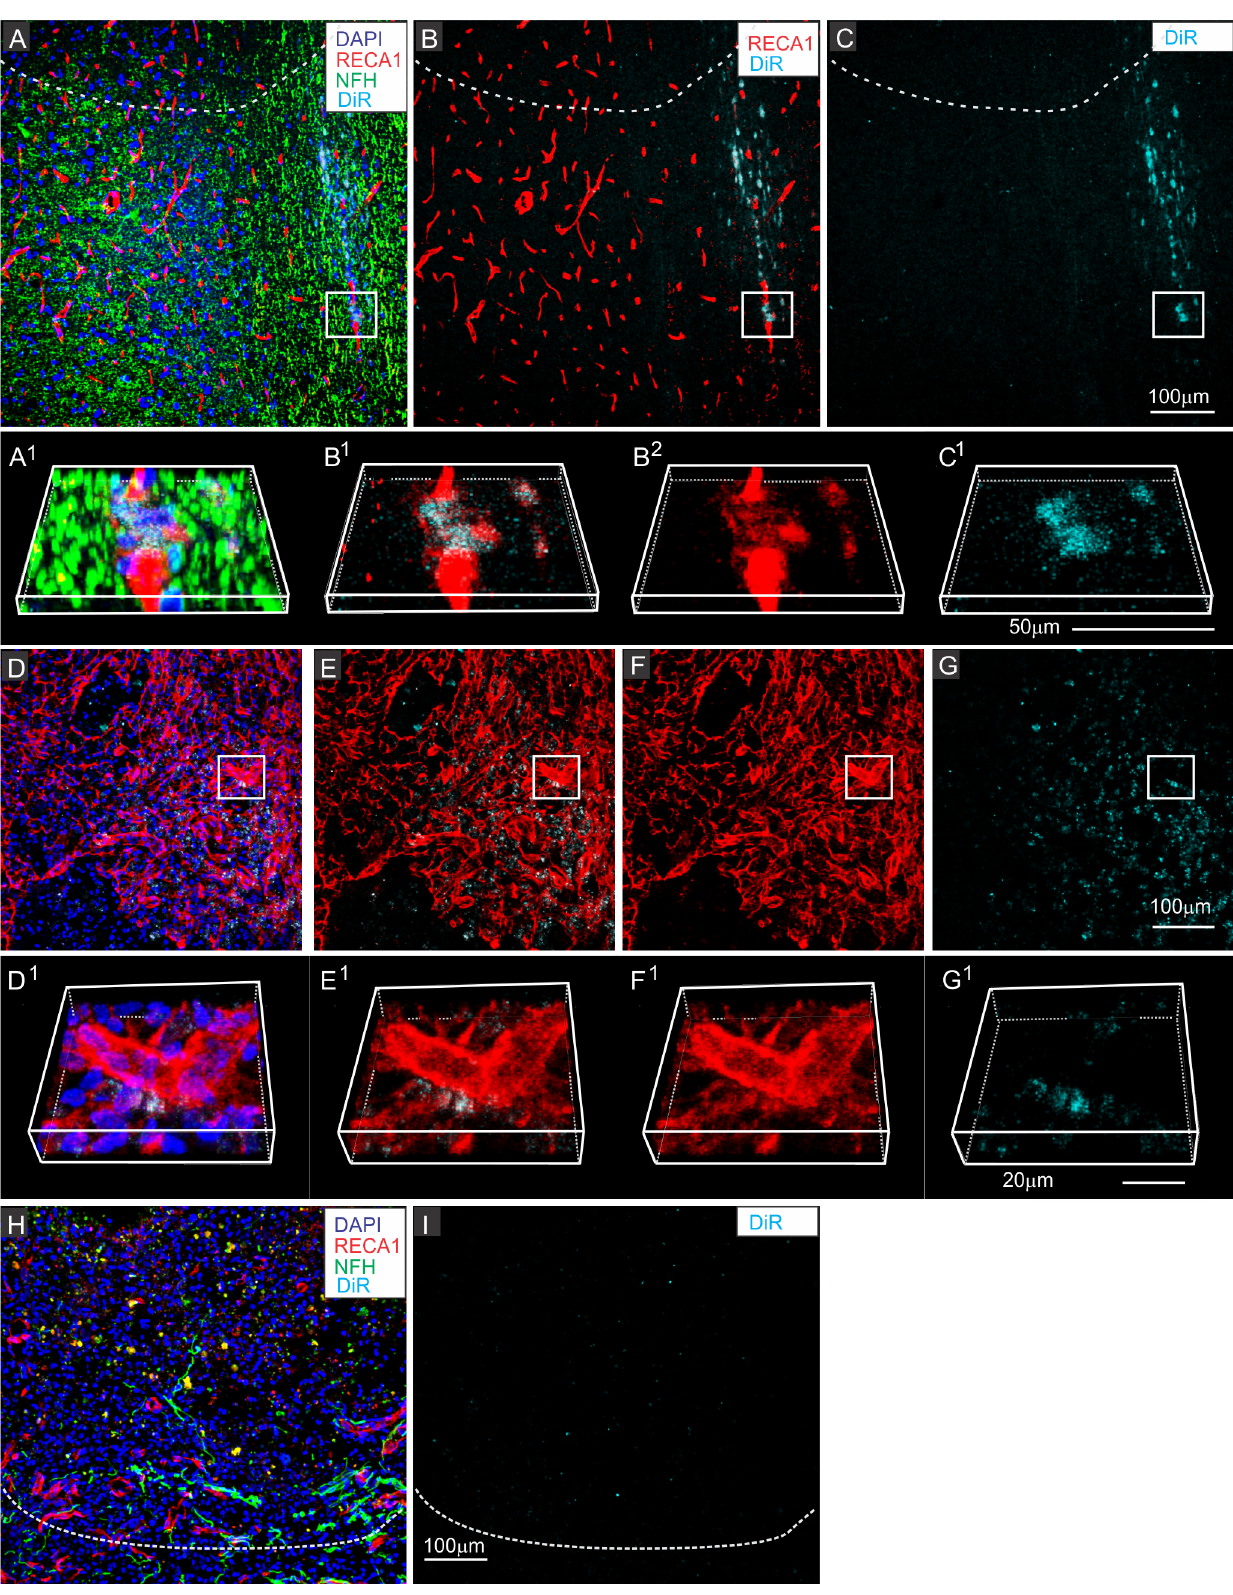
Fig 6. DiR hotspots not detected in other cell types at the lesion site. Selected regions contused spinal cords 24 hours after infusion of DiR MSC exos (A-G) or PBS with free DiR (G-H), showing close proximity between DiR hotspots and some endothelial cells (A-C) and pericytes (D-G) within the central scar